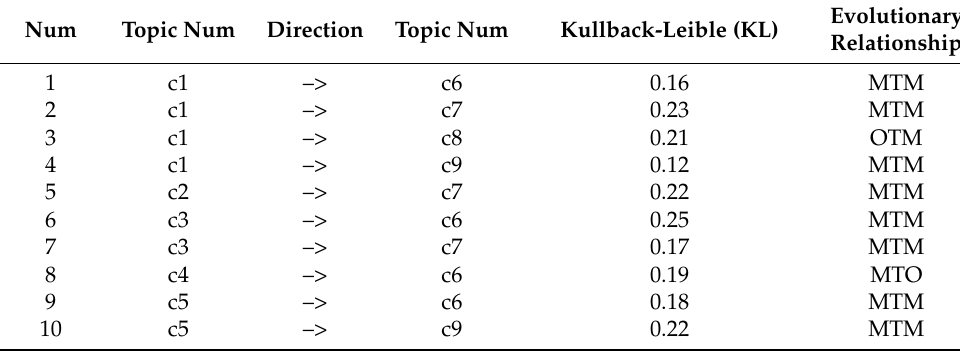
Table 8. The evolutionary relationship of SRP